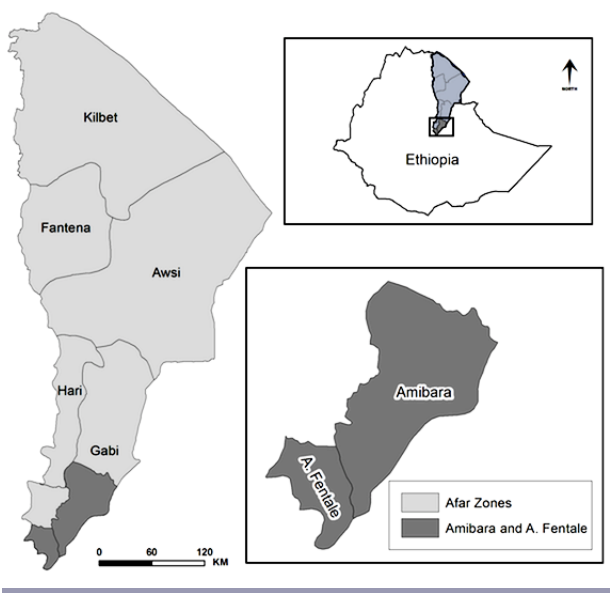
Fig. 2 . Left: Afar region divided by its five administrative zones. Upper Right: Afar region in relation to Ethiopia. Lower Right: Close up of the two districts ( woredas ) where we collected focus group and field